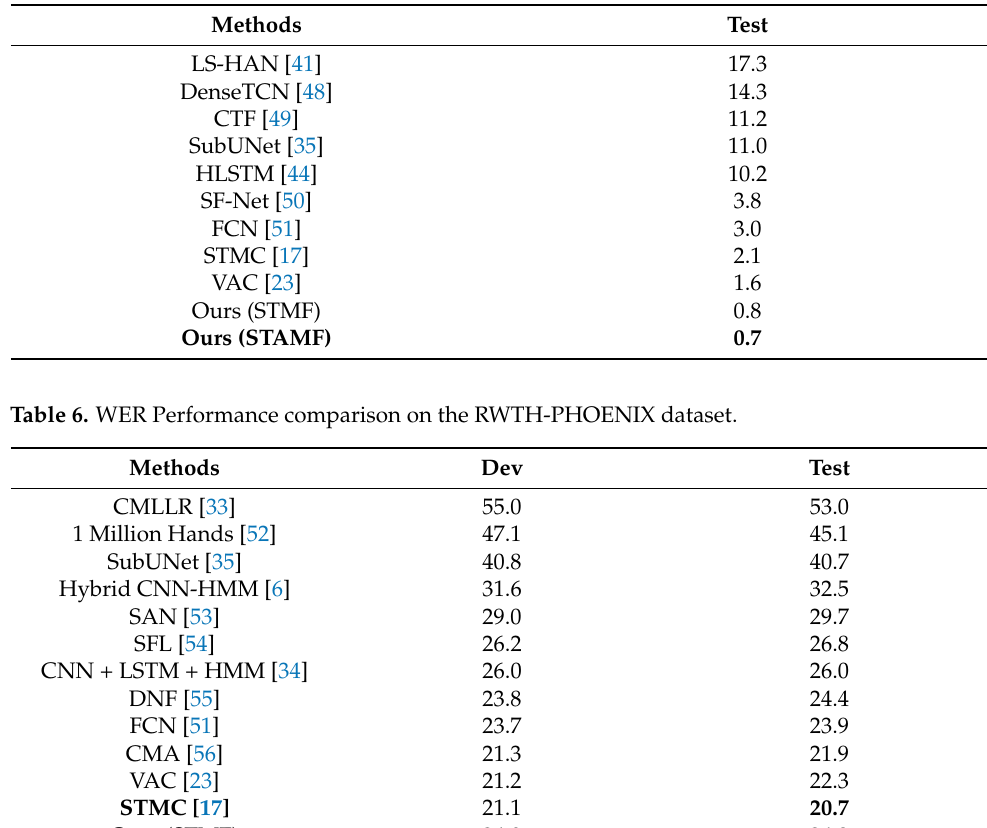
Table 5. WER Performance comparison on the CSL dataset.